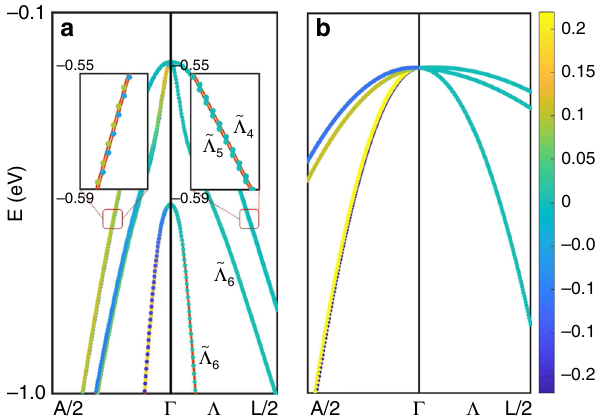
Fig. 3 BSVSP in bulk GaAs. a Band structure and the x component of spin polarizations of bulk GaAs calculated by DFT. The y and z components have the same behavior. The coordinates of symmetry points A and L are (0.5, 0.25,0) and (0.5, 0.5, 0.5), respectively. The irreducible representation ~ Λ 4 and ~ Λ 5 are one dimensional. The irreducible representation ~ Λ 6 is two dimensional. b Band structure and the x component of spin polarizations of bulk GaAs calculated by the k · p